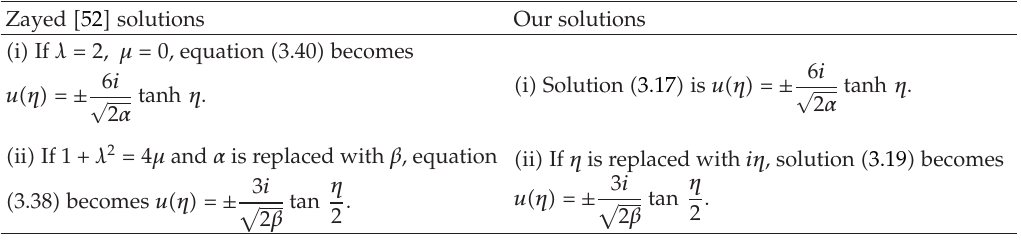
Table 1: Comparison between Zayed (cid:6) 52 (cid:7) solutions and our solutions. Zayed (cid:6) 52 (cid:7) solutions Our